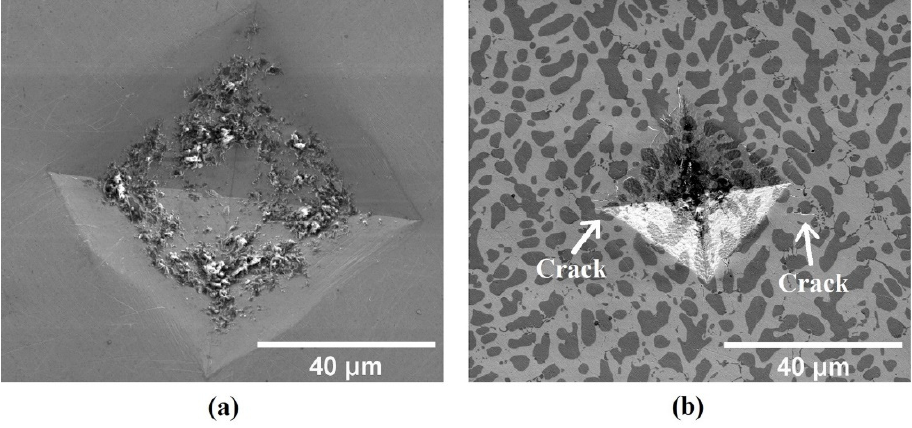
Figure 4. SE-SEM micrographs of HEA indents; ( a ) CrFeCoNi and ( b ) CrFeCoNiSn alloys.